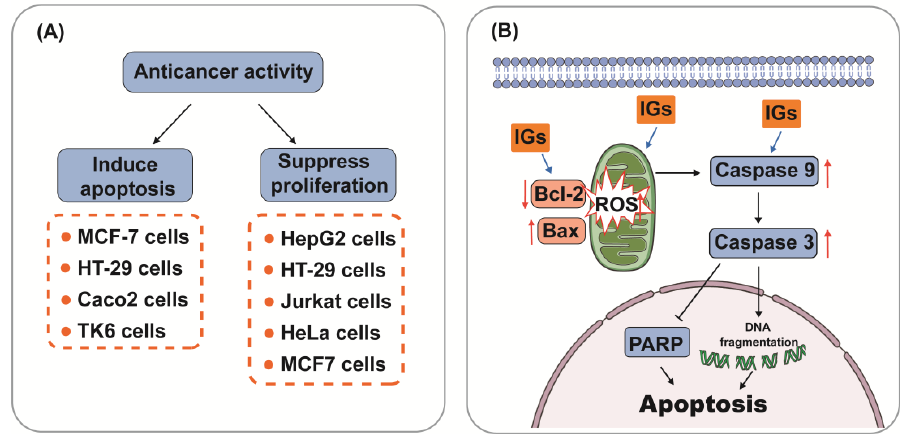
Figure 4. Anticancer activity ( A ) and mechanism of regulating the apoptotic pathway ( B ) of IGs. Furthermore, isorhamnetin 3- O -glucoside ( 4 ) (10 µ M) exerted its inhibitory effects on matrix metalloproteinase-9 and -2 in HT1080 human fibrosarcoma cells by interfering with activator protein-1 transcription factor binding [165]. Isorhamnetin-3,7-diglucoside ( 18 ) (50–100 µ g/mL) induced a 20% decrease in cancer intestinal cell survival through glycogen synthase kinase 3-beta regulation in intestinal cells